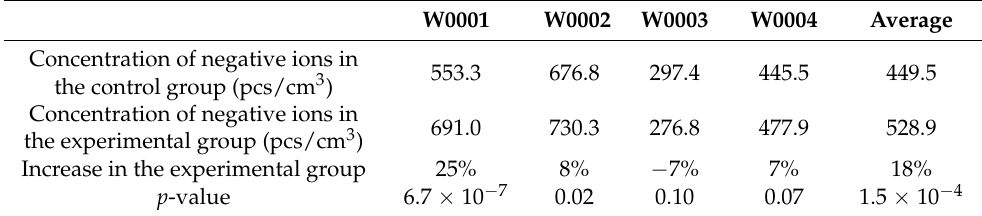
Table 11. Comparison of particle counts by the station in Wushaoling.